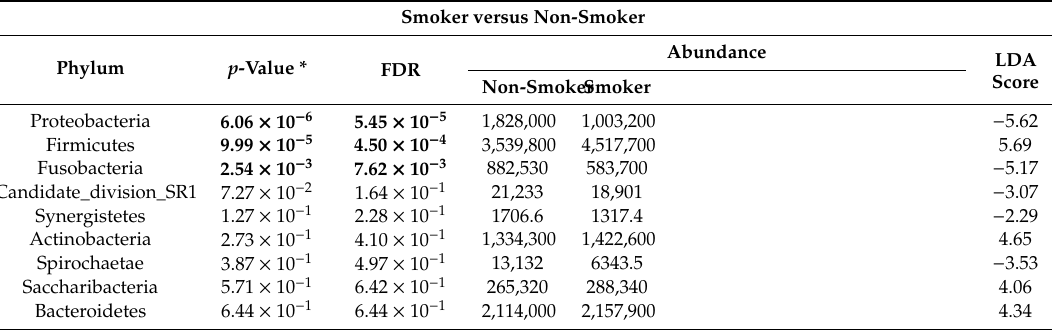
Table 5. Important taxonomic features at the phylum level identified by